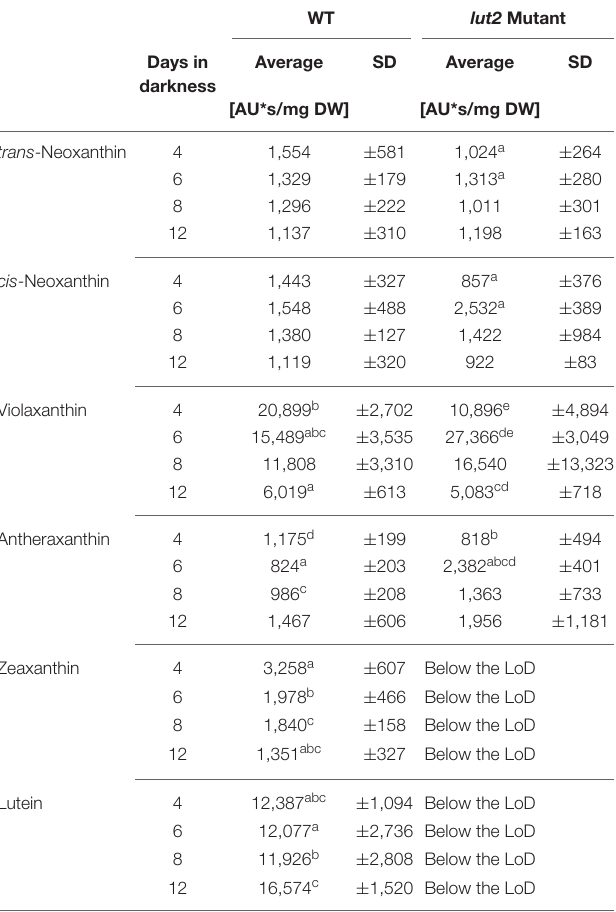
TABLE 2 | The relative content of identified xanthophylls in etiolated seedlings of WT and lut2 mutant.